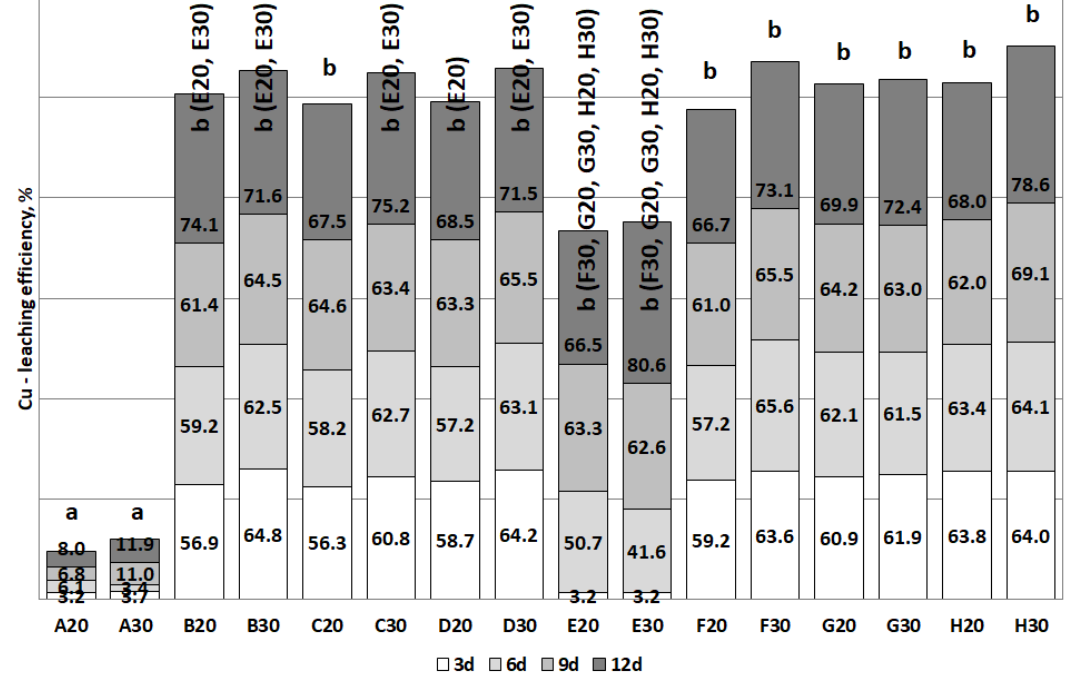
Figure 10. Bioleaching efficiency of Cu during the experiment (Statistical groups a and b ).